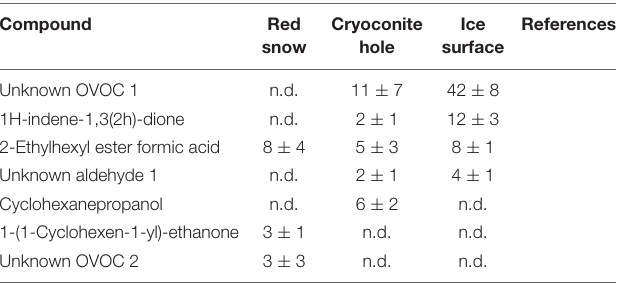
TABLE 7 | Mean (ng m − 2 h − 1 ± SE) OVOC emissions measured in three microbiological habitats on the southern Greenland ice sheet.